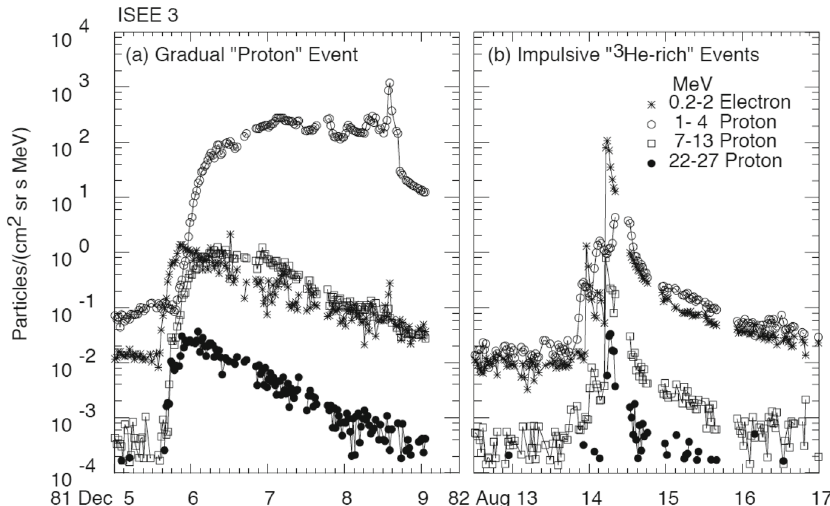
Fig. 21 Particle spectra of a gradual SEP event (left) and two consecutive impulsive events (right) as observed by the ISEE 3 spacecraft. Image reproduced by permission from Reames (1999), copyright by